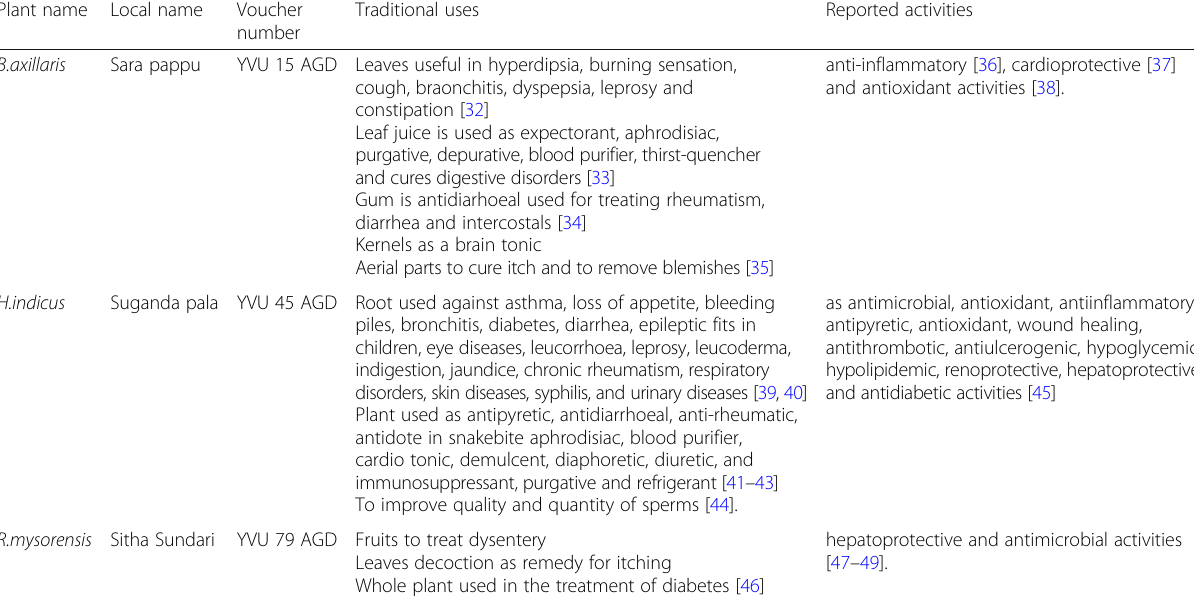
Table 1 Indian medicinal plants used in the present study and their ethnomedicinal